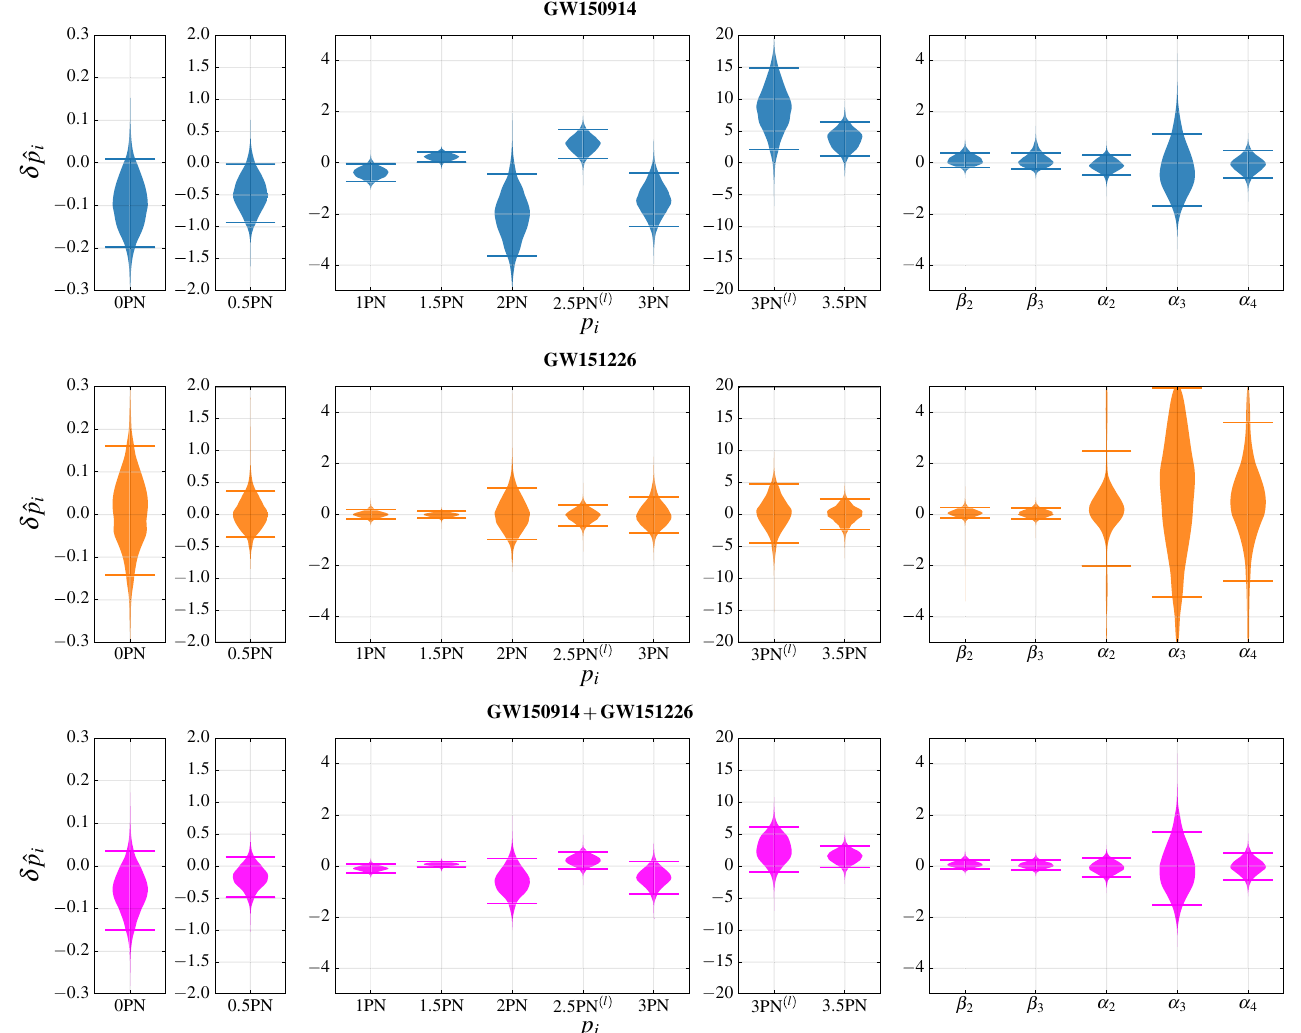
FIG. 2. This is the corrected Fig. 7 of [4], showing the posterior density distributions and 90% credible intervals for the relative deviations PN parameters p i , as well as intermediate parameters β i and merger-ringdown parameters α i . The corrected posterior for the 0.5 PN single-parameter analysis peaks below 0, while previously reported to peak above; the posterior is still consistent with